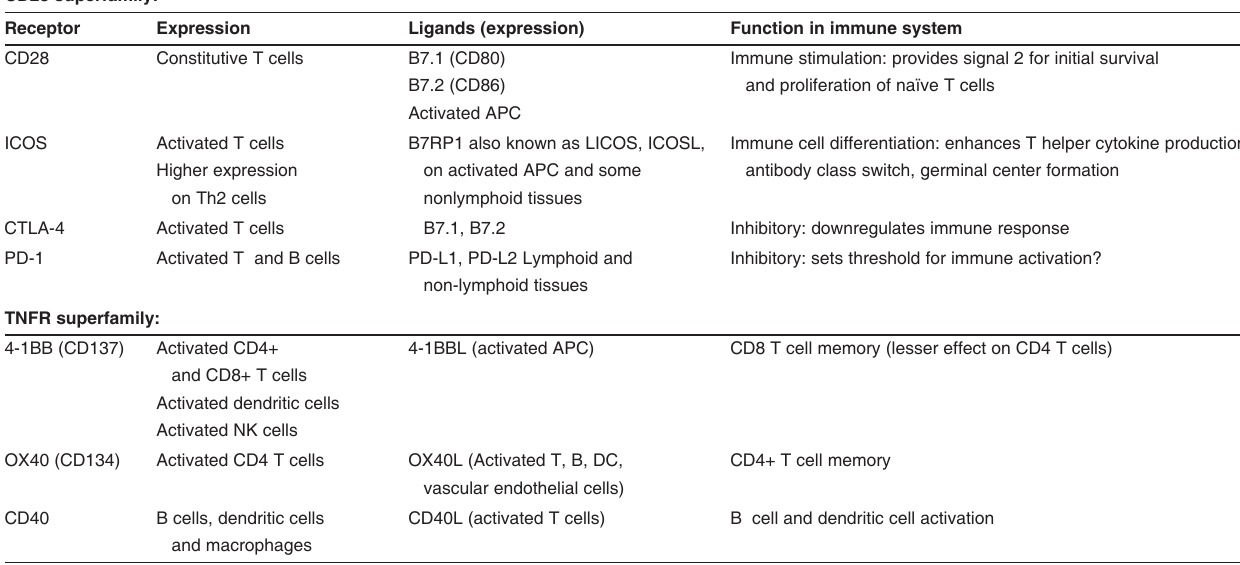
TABLE 1 Costimulatory molecules in T cell